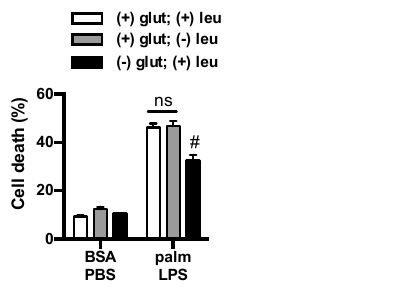
Figure 4. Inhibition of glutaminolysis partially mimics glutamine deficiency. ( A , B ) Primary macrophages were stimulated with BSA-PBS in the presece of the glutaminolysis inhibitors BPTES (( A ) 10 µ M) or C698 (( B ) 10 µ M); ( C ) IL-1 β release was quantified from pMACs treated with palm-LPS in the presence of BTPES of C968. Bar graphs report the mean ± SE for a minimum of 3 experiments, each performed in triplicate. * , p < 0.05 for veh vs . inhibitor. 3.3. Glutamine Deficiency Is Protective Independent of Leucine Glutamine is required for the cellular import of branched chain amino acids such as leucine [20]. Thus, a possible catabolism ‐ independent function of glutamine deprivation could be explained by reduced leucine uptake. To investigate whether leucine deprivation could mimic the effects of glutamine removal we used media deficient in glutamine or leucine and analyzed macrophage cell death. Removal of leucine from glutamine containing media did not protect the macrophages from cell death (Figure 5). Thus, the phenotype of glutamine deficiency cannot be explained by reduced uptake and metabolism of leucine.